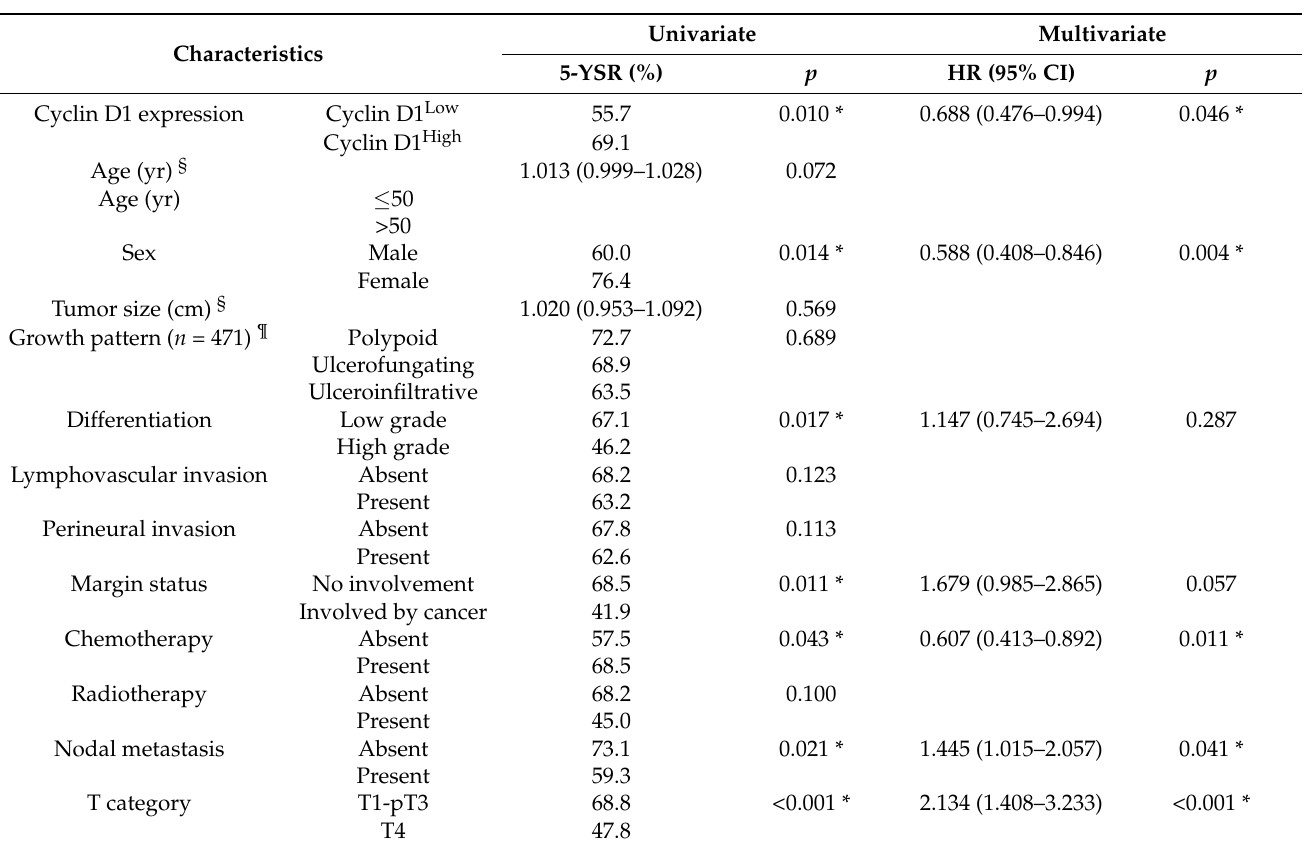
Table 4. Association between clinicopathological factors and RFS in 495 patients with